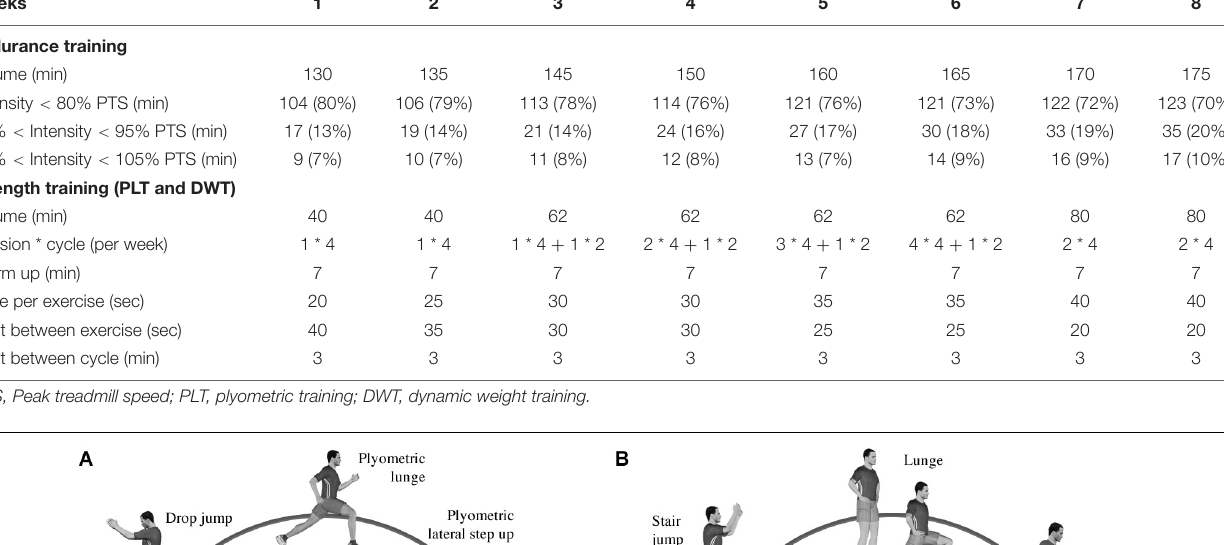
were measured by the Optojump Next R (cid:13) system. The average mechanical power during the positive (concentric) work per body mass (5RJ-P, in W · kg − 1 ) was then calculated on the basis of the methods described by Bosco et al. (1983) using the following formula (Eq. 2).